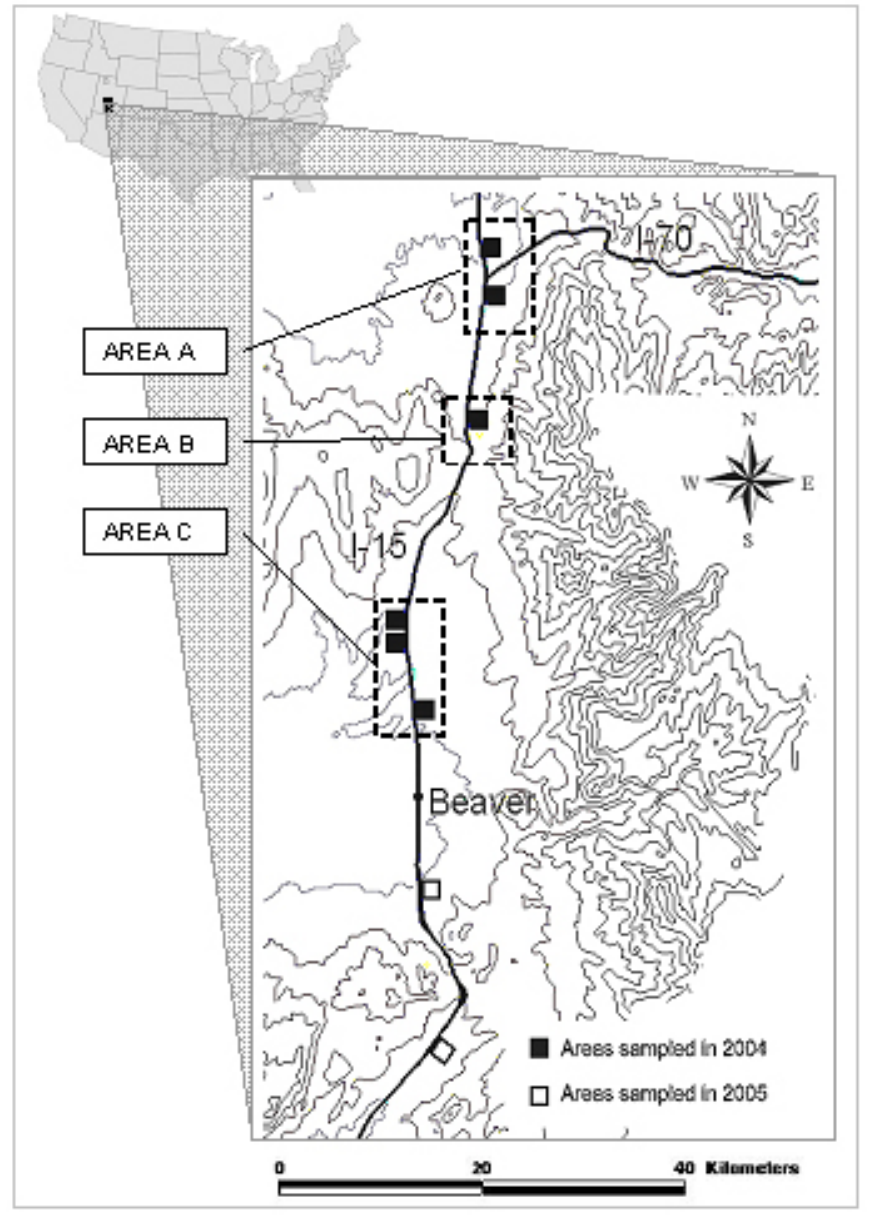
Figure 1. Study-area map with trapping location in 2004 and 2005 and geographic areas (A, B, and C) used for comparison of densities in 2004 in southern Utah,